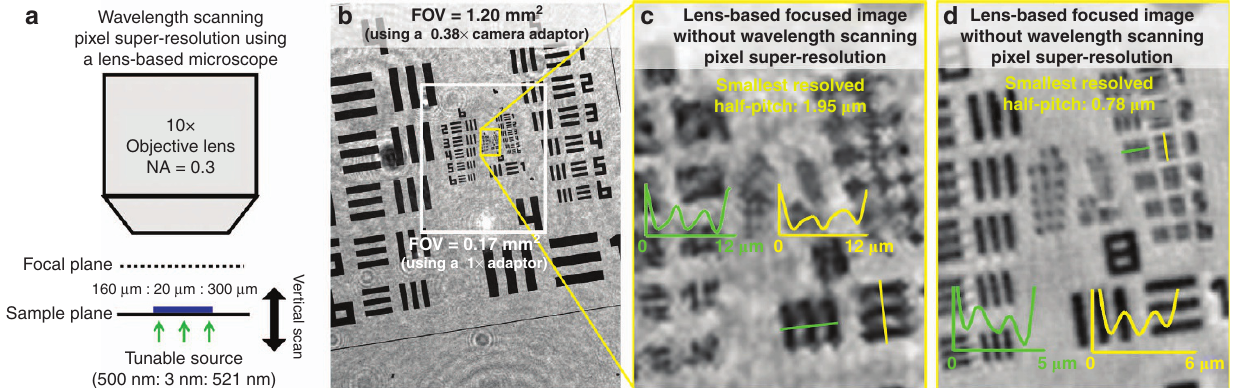
Wavelength scanning pixel super-resolution using a lens-based microscope